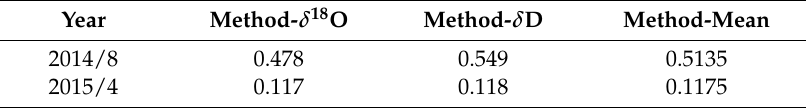
Table 3. The E / I ratios calculated based on δ 18 O or δ D and their mean values.